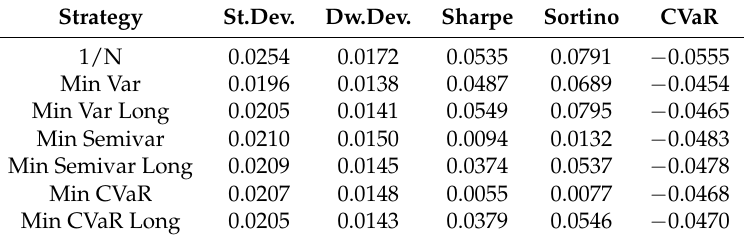
Table 4. 10 year rolling window